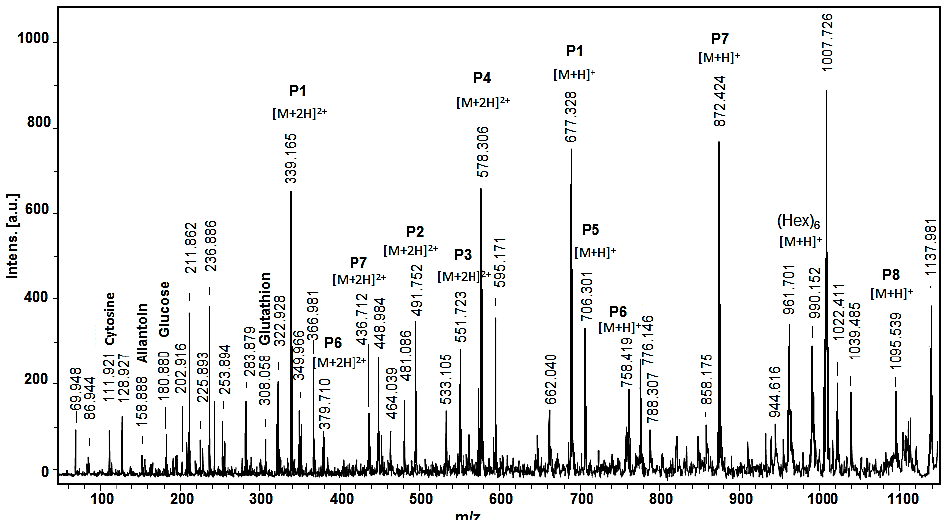
Figure 3. MALDI-MS spectrum of the fraction with compounds with Mw < 1 kDa from the mucus of the garden snail Helix aspersa . Standard peptide solution was used to calibrate the mass scale of the AutoflexTM III, High Performance MALDI-TOF & TOF/TOF Systems (Bruker Daltonics, Bremen, Germany).